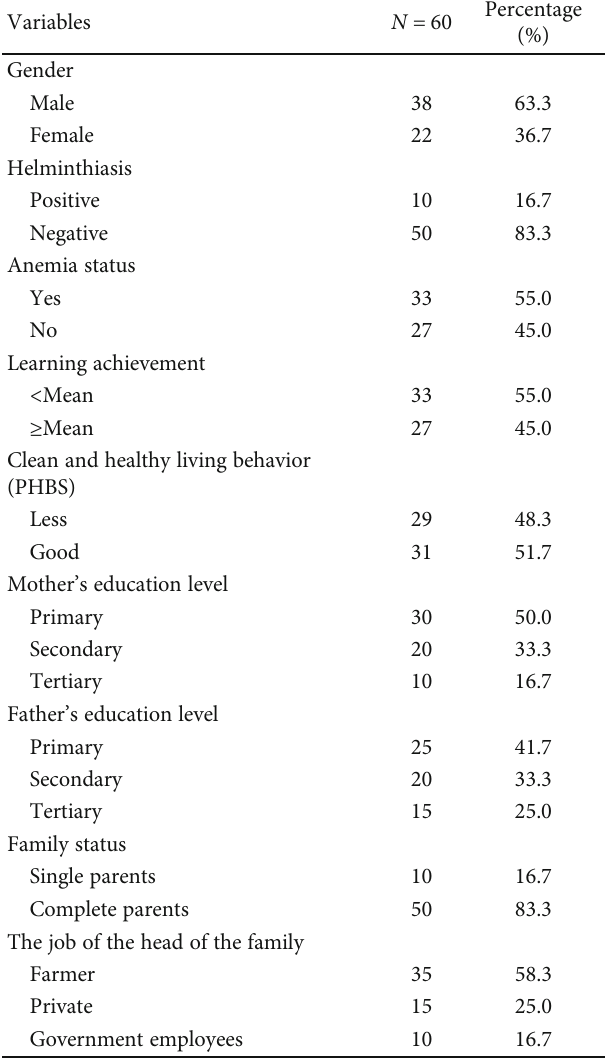
Table 1: Characteristics of